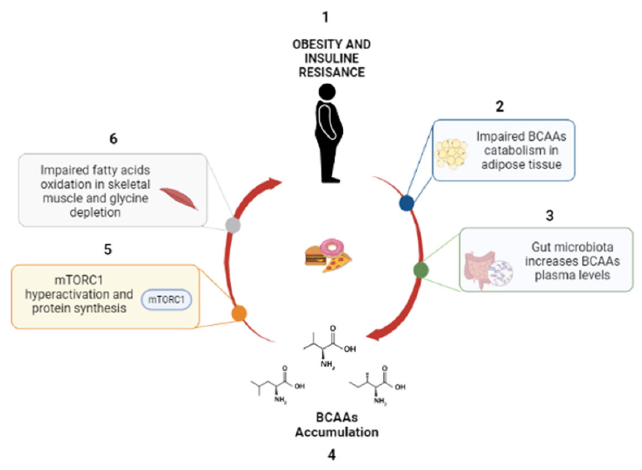
Figure 3. Role of BCAAs in OB. (1) OB and IR alter the catabolism of BCAAs; (2) gut microbiota implement BCAA levels, (3) causing BCAA accumulation (4), mTORC1 activation (5) and inhibition of lipolysis (6).